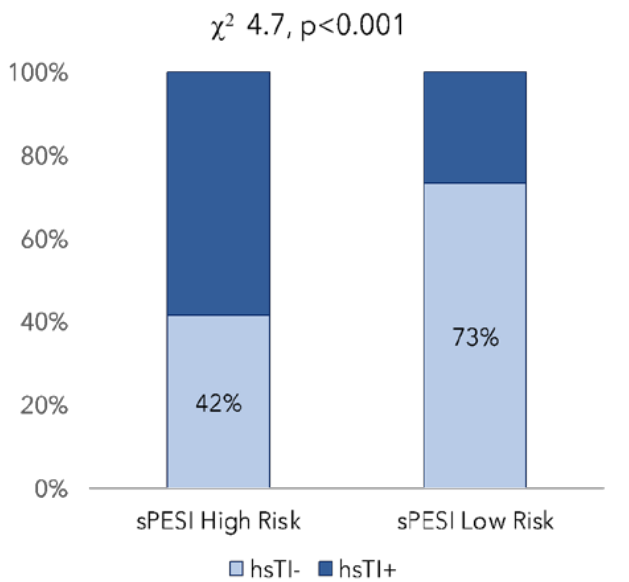
Figure 1. Comparison of the hs-cTnI+ group with the hs-cTnI − group in the sPESI risk class and sPESI low risk class respectively, in RS analysis.